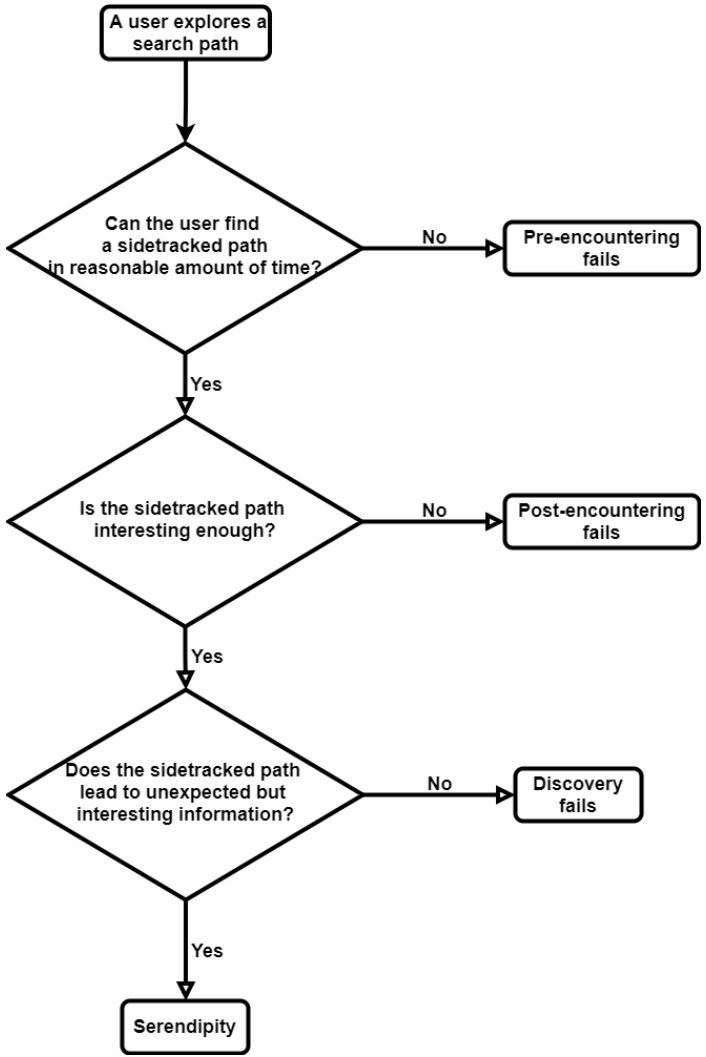
Figure 2. A flow diagram of how a user may experience a